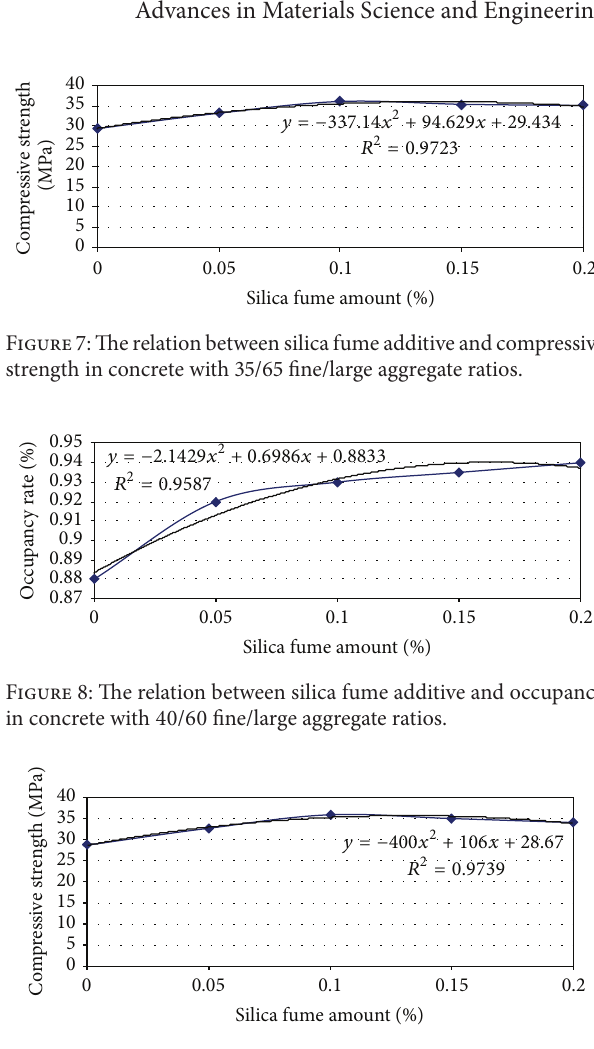
Figure9: Therelation between silica fumeadditive andcompressive strength in concrete with 40/60 fine/large aggregate